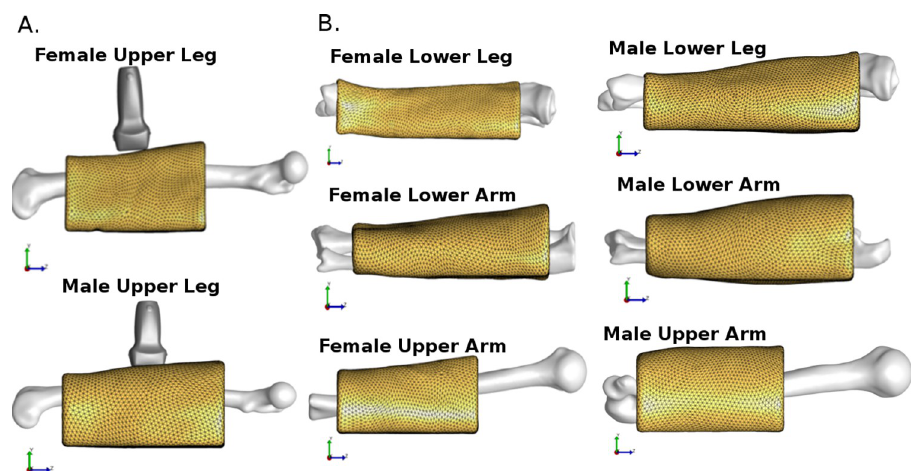
Fig 4. Overview of the built lumped models. A. Layout of the probe, bone, and flesh components for the female and male upper leg models. B. Bone and flesh components for the remaining six models.